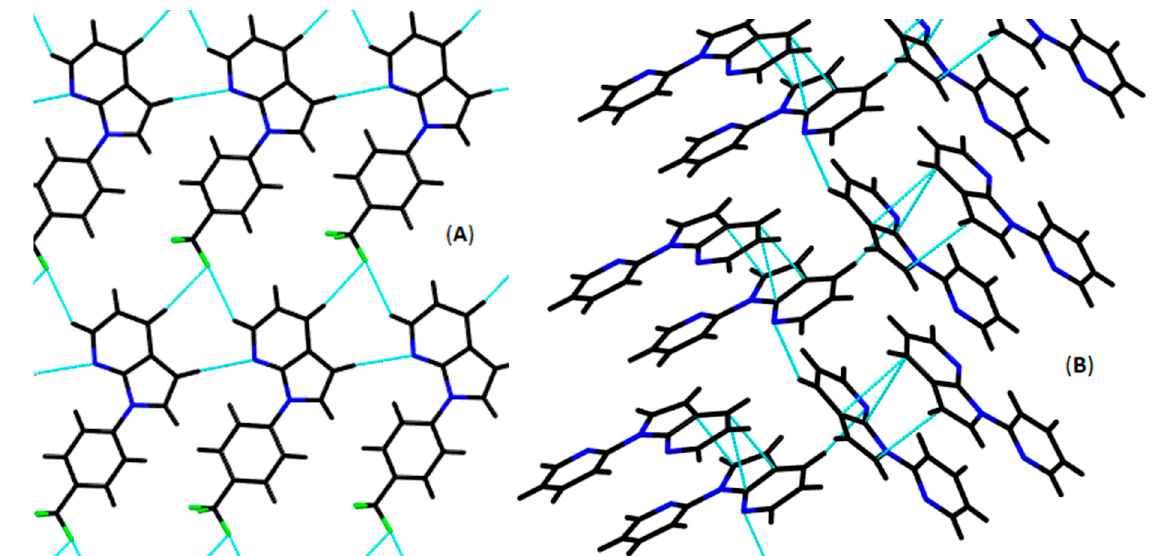
Figure 3. Short-contact networks observed for 1e ( A ) and 1i ( B ).